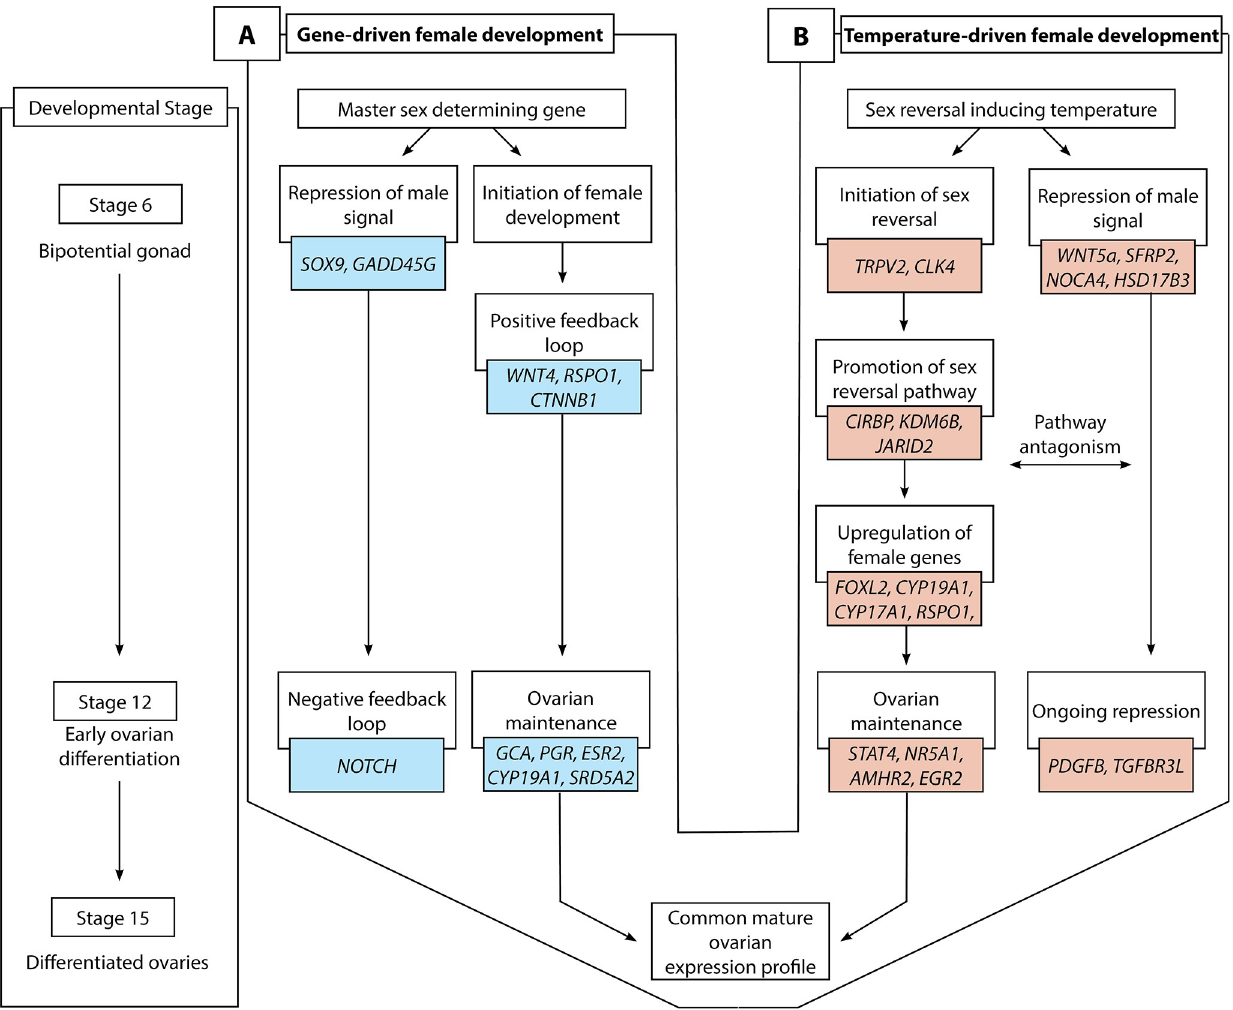
Fig 2. Schematic overview of gene-driven (blue) and temperature-driven (red) female developmental pathways in Pogona vitticeps . The pathways are initially different (from stages 6 to 12), but they ultimately converge on highly similar expression profiles when ovarian differentiation has occurred by stage 15. Both pathways are characterised by repression of a male signal, however this signal is stronger in temperature-driven females and appears to require ongoing repression when compared with the gene-driven